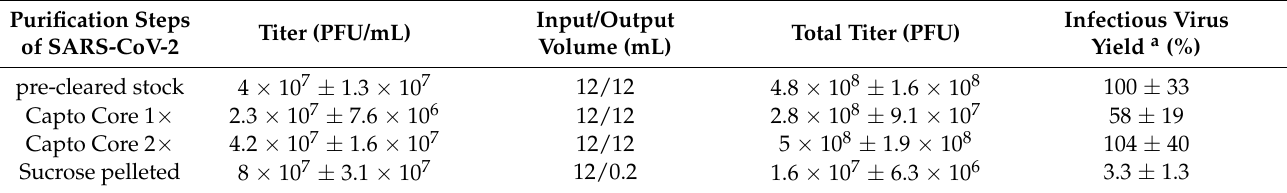
Table 1. Comparison of virus yields and purity.